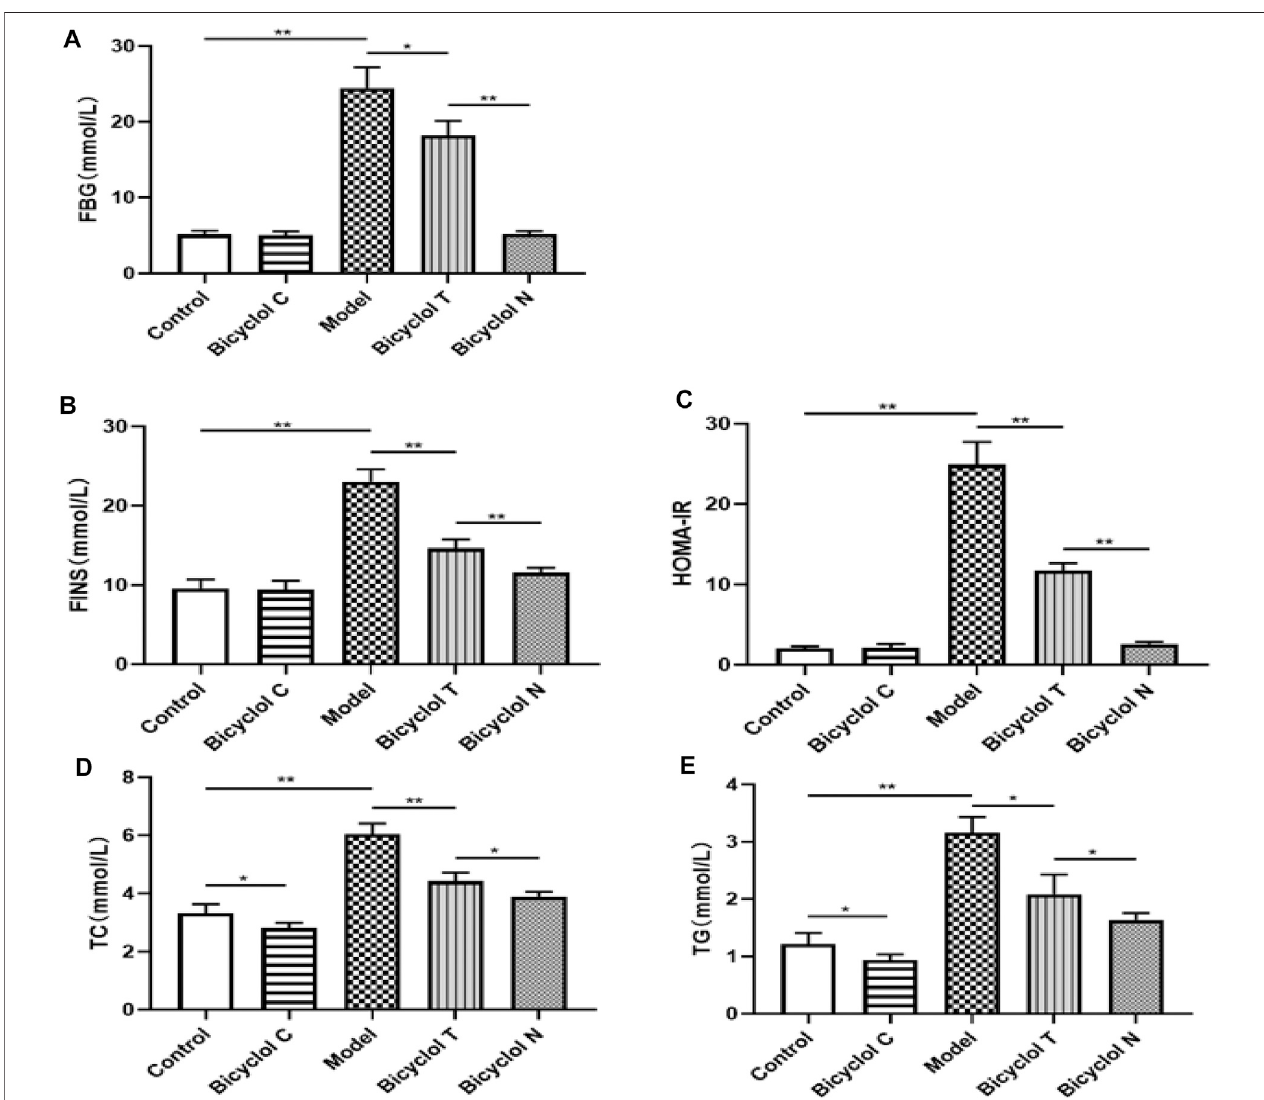
FIGURE3| EffectofbicyclolonbloodlipidandglucoselevelsinT2DM – NAFLDrat (A) FBG. (B) FINS. (C) HOMA-IR. (D) TC. (E) TG.Dataarepresentedasmeans ± SD. * p < 0.05. ** p < 0.01.